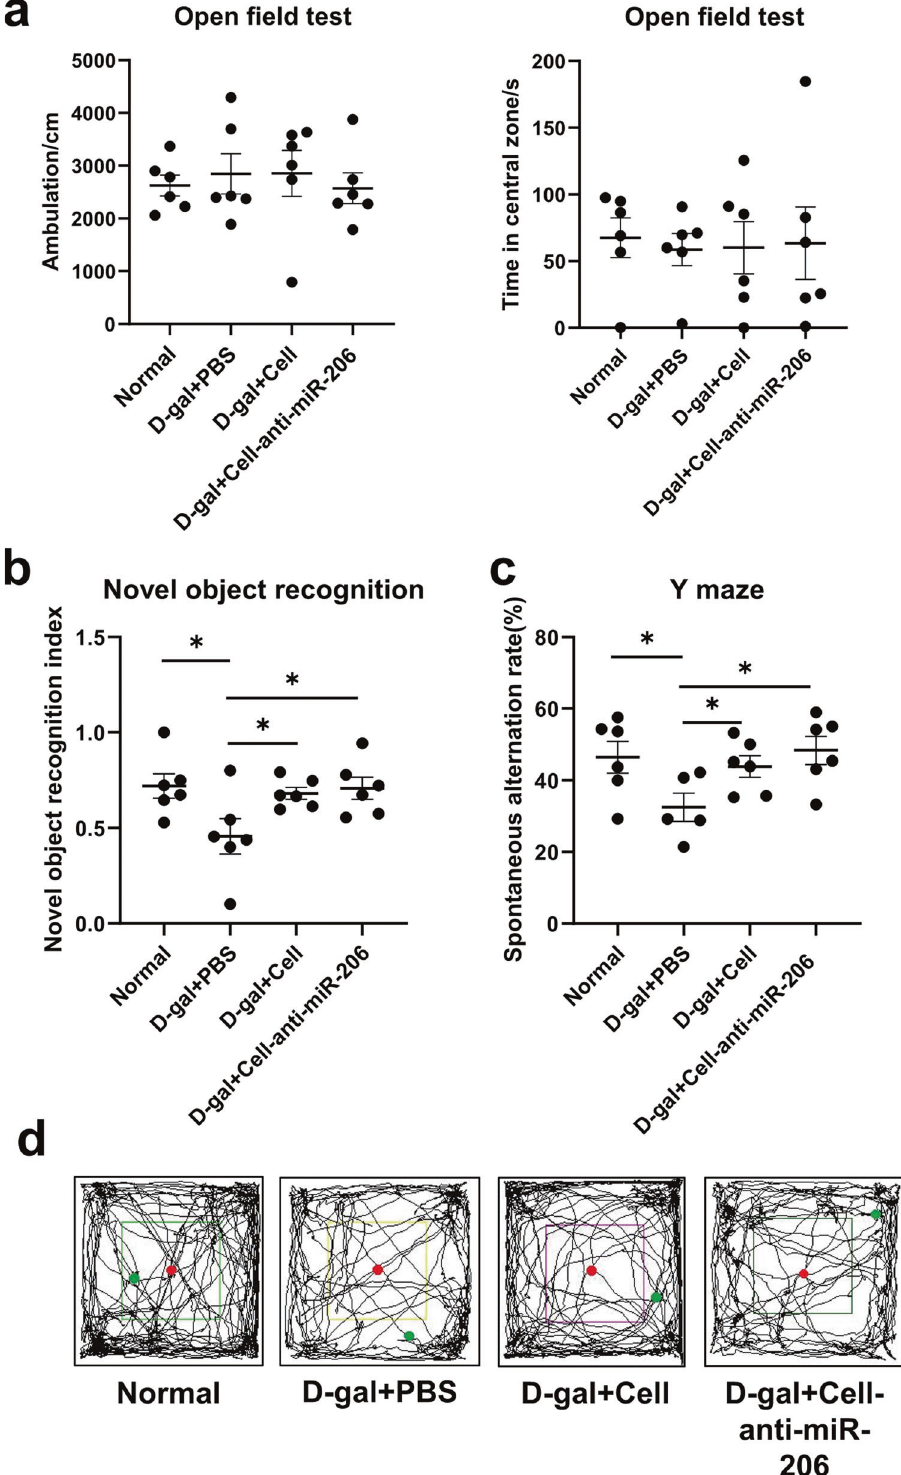
Fig. 2 Learning and spatial memory were restored in mice after stem cell transplantation. a OFT experimentation of spontaneous movement ability and anxiety of mice. b The learning and memory ability of mice tested by NOR. c The spatial memory ability of mice tested by Y-maze. d Spontaneous movement of mice in an open fi eld trajectory diagram. The results were expressed as the Mean ± SD, * p < 0.05, versus D-gal + PBS groups, n = 6.